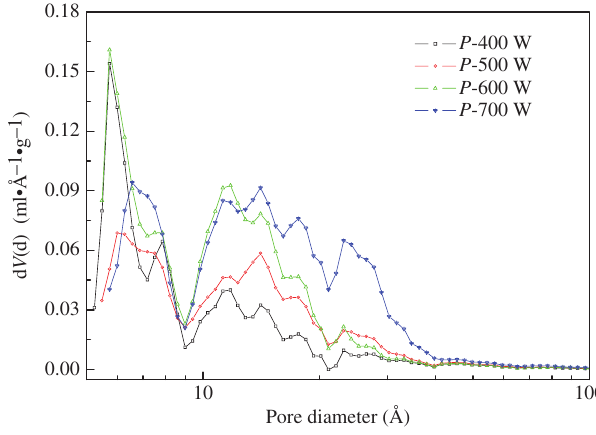
Figure 2: Pore size distribution chart for different microwave power.